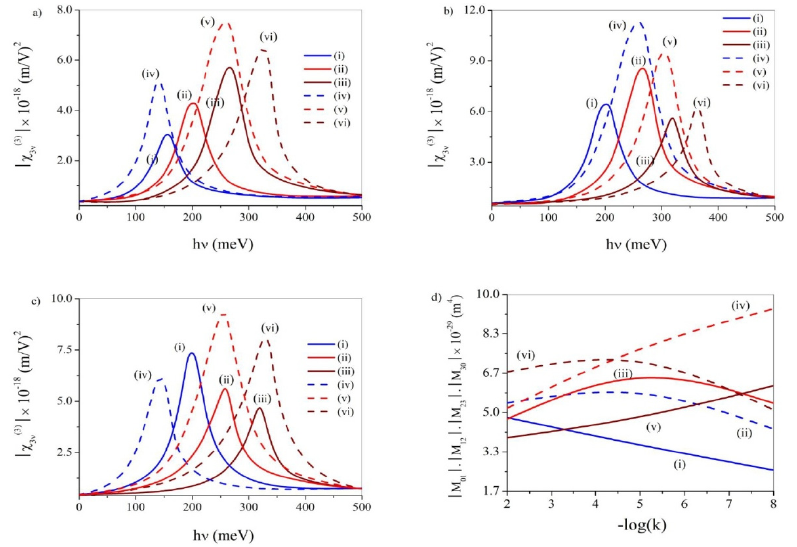
Figure 9. THG vs. h υ diagrams ( a ) devoid of noise, ( b ) under ADWN and ( c ) under MLWN. In these diagrams the anharmonicity has (i) odd parity and k = 10 − 8 , (ii) odd parity and k = 10 − 5 , (iii) odd parity and k = 10 − 2 , (iv) even parity and k = 10 − 8 , (v) even parity and k = 10 − 5 , (vi) even parity and k = 10 − 2 . ( d ) Depiction of GF for THG vs. − log(k): (i) devoid of noise and OPA, (ii) devoid of noise and EPA, (iii) with ADWN and OPA, (iv) with ADWN and EPA, (v) with MLWN and OPA and (vi) with MLWN and